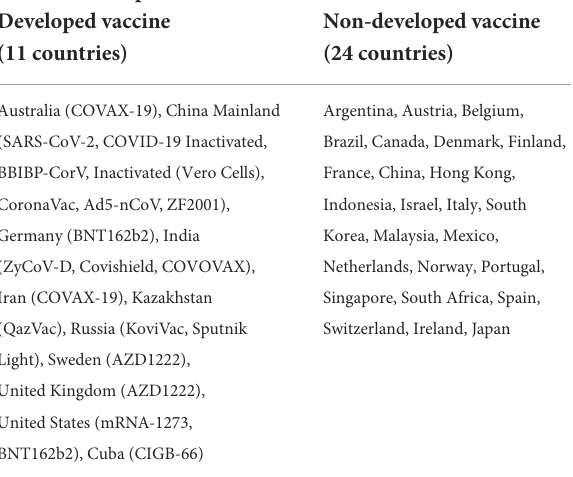
TABLE 1 List of countries selected, and vaccines developed. Vaccine